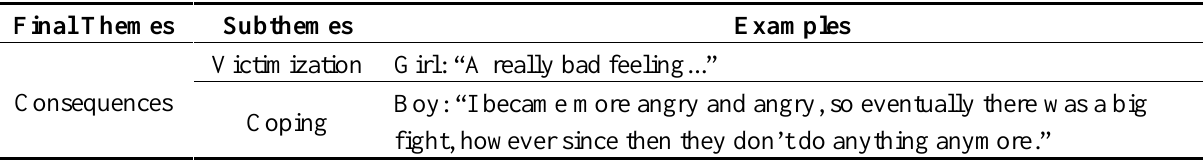
Table 9. Main themes, subthemes and examples of consequences of (coping with) (cyber)bullying